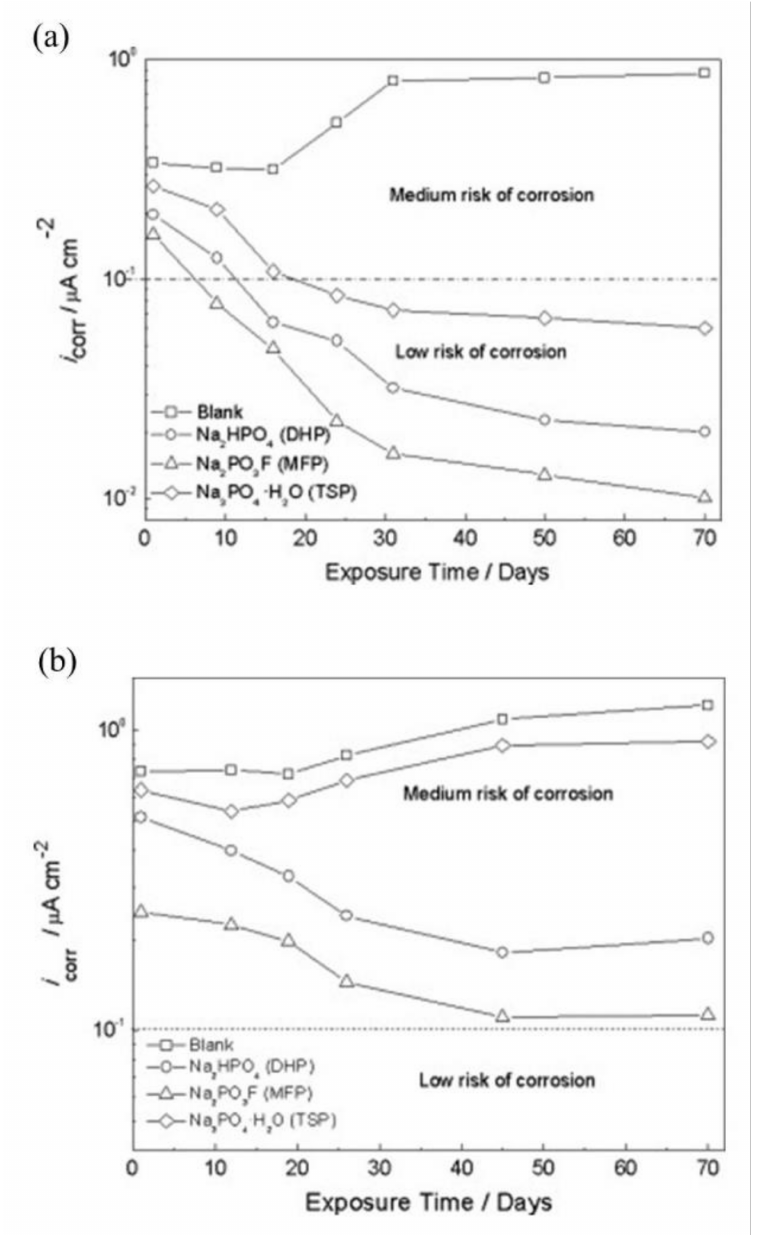
Figure 19. Corrosion current density ( i corr ) versus time for steel in 3.5 wt.% NaCl in the presence of: ( a ) migrating corrosion inhibitor (MCI), and ( b ) admixture corrosion inhibitor (ACI) [46]. Reproduced with permission from Bastidas, D.M. et al., Cem. Conc. Comp.; published by Elsevier,